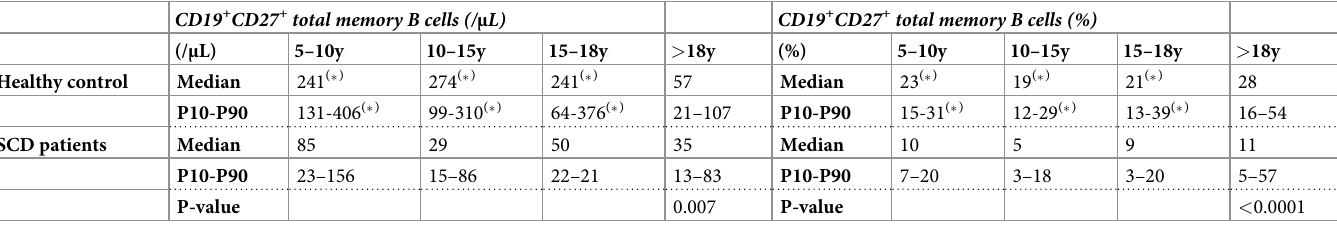
Table 3. Total memory B cells according to